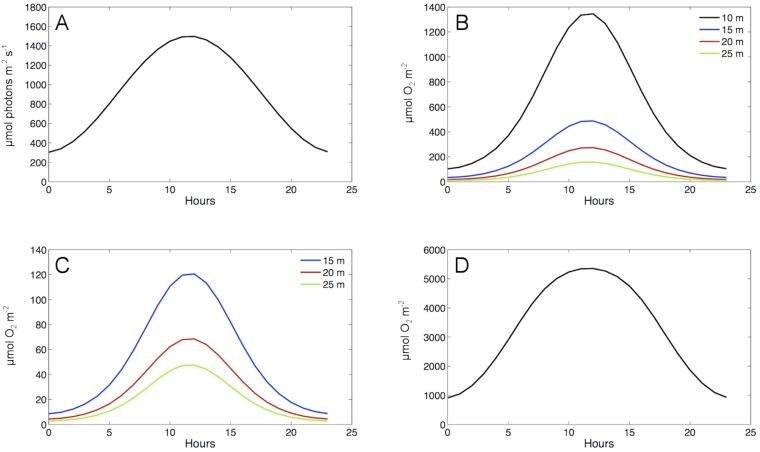
Model estimates of surface PAR (A) and hourly O2 production rate by algal functional groups over a 24 h period.Algal groups include foliose red (B), crustose coralline (C), and sea ice algae (D). Colored lines indicate estimated O2 production at different depths.